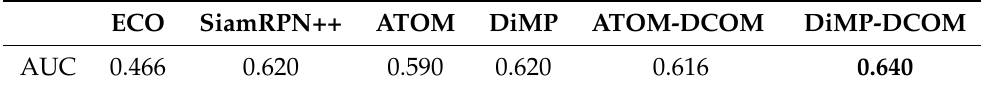
Figure 4. Comparisons with state-of-the-art trackers on NfS [23] in terms of success plots. Table 6. Comparisons with the state-of-the-art trackers on